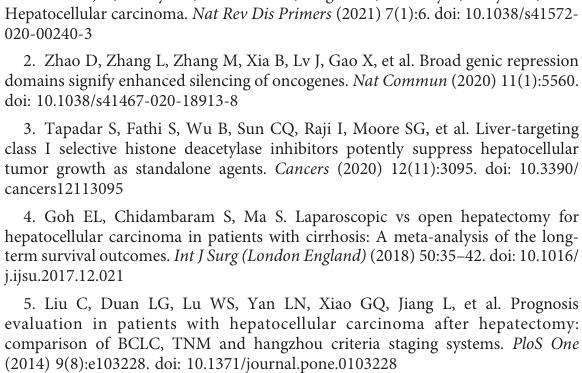
SUPPLEMENTARY FIGURE 1 The prognosis of 6 mitochondria-related genes were investigated by survival analysis with optimal cut-off expression. (A) MTHFD1L. (B) NT5DC2. (C) POLQ. (D) RECQL4. (E) TOMM40L. F) TXNRD1. P < 0.05. SUPPLEMENTARY FIGURE 2 Analysisoftherelationshipbetweenimmunecheckpointsandriskgroups, risk score. (A) CTLA4. B) CXCR2. (C) GPC3. (D) HAVCR2. (E) PDCD1. (F) CD274. P < 0.05. SUPPLEMENTARY FIGURE 3 Analysis of drug sensitivity based on risk groups and clusters. (A, F) Imatinib. (B, H) Tipifarnib. (C, I) Epothilone. (D, J) Doxorubicin. (E, K) Bosutinib. P <